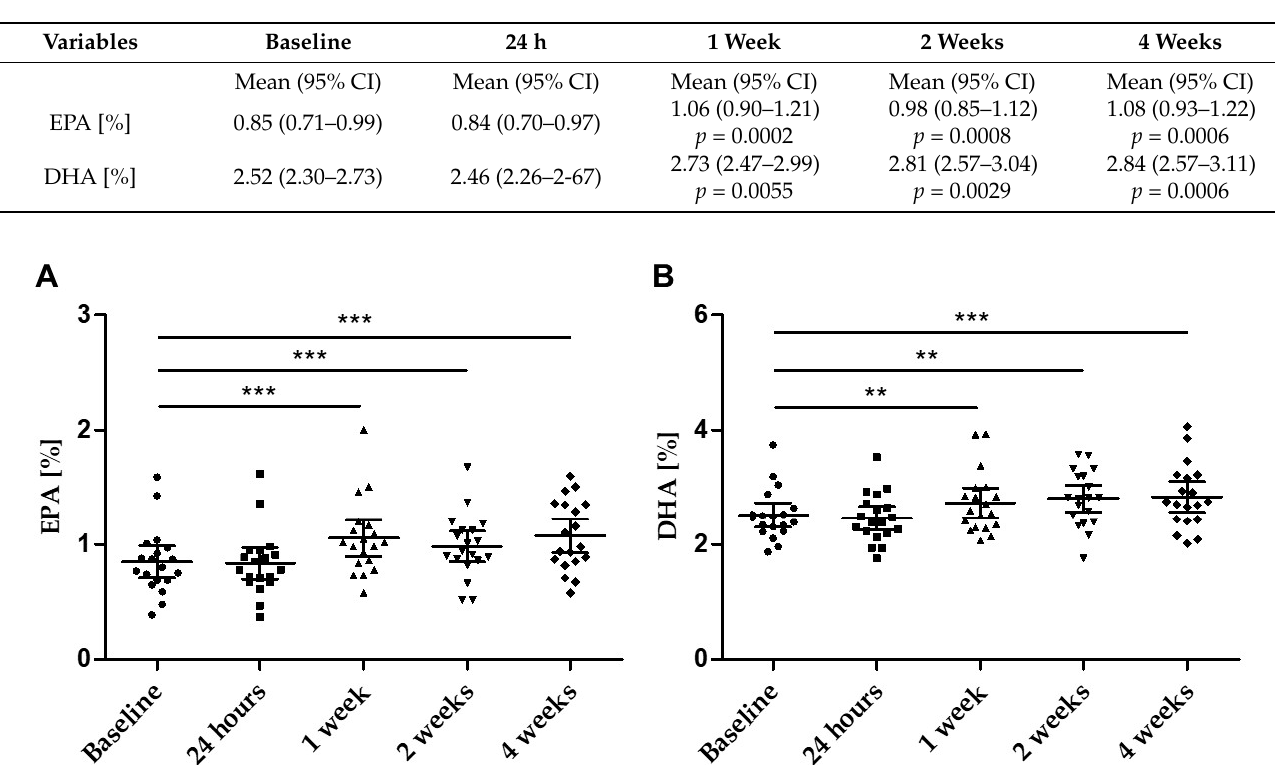
Table 3. EPA and DHA in fasting plasma samples ( n = 19).